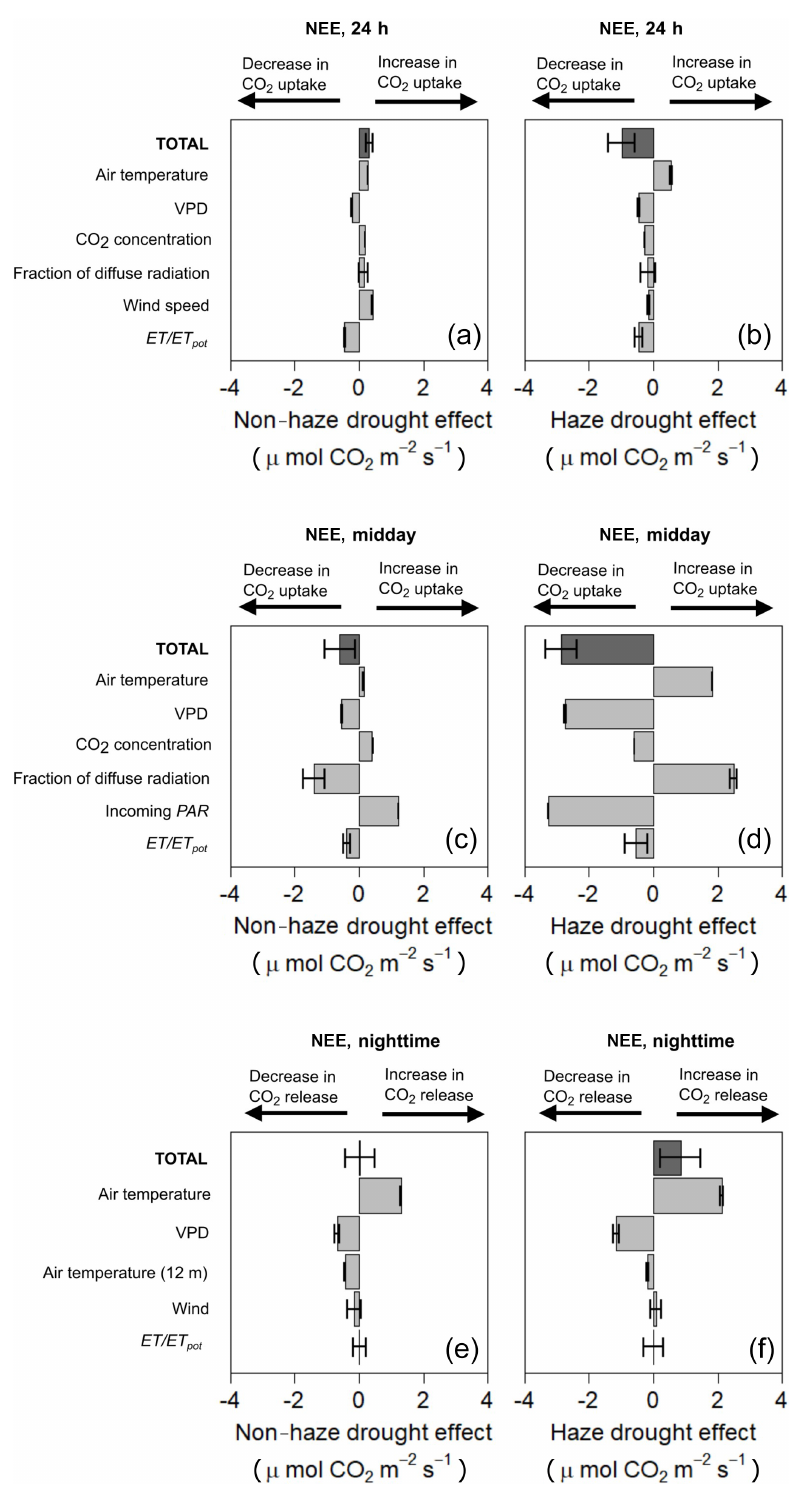
Figure 6. Contribution and effect of meteorological and environmental parameters during the non-haze drought and haze drought period on the 24h (a, b) , midday (c, d) and night-time (e, f) net ecosystem CO 2 exchange (NEE) compared to non-drought and non-haze conditions using a multiple linear regression model (MLRM). Error bars show the standard